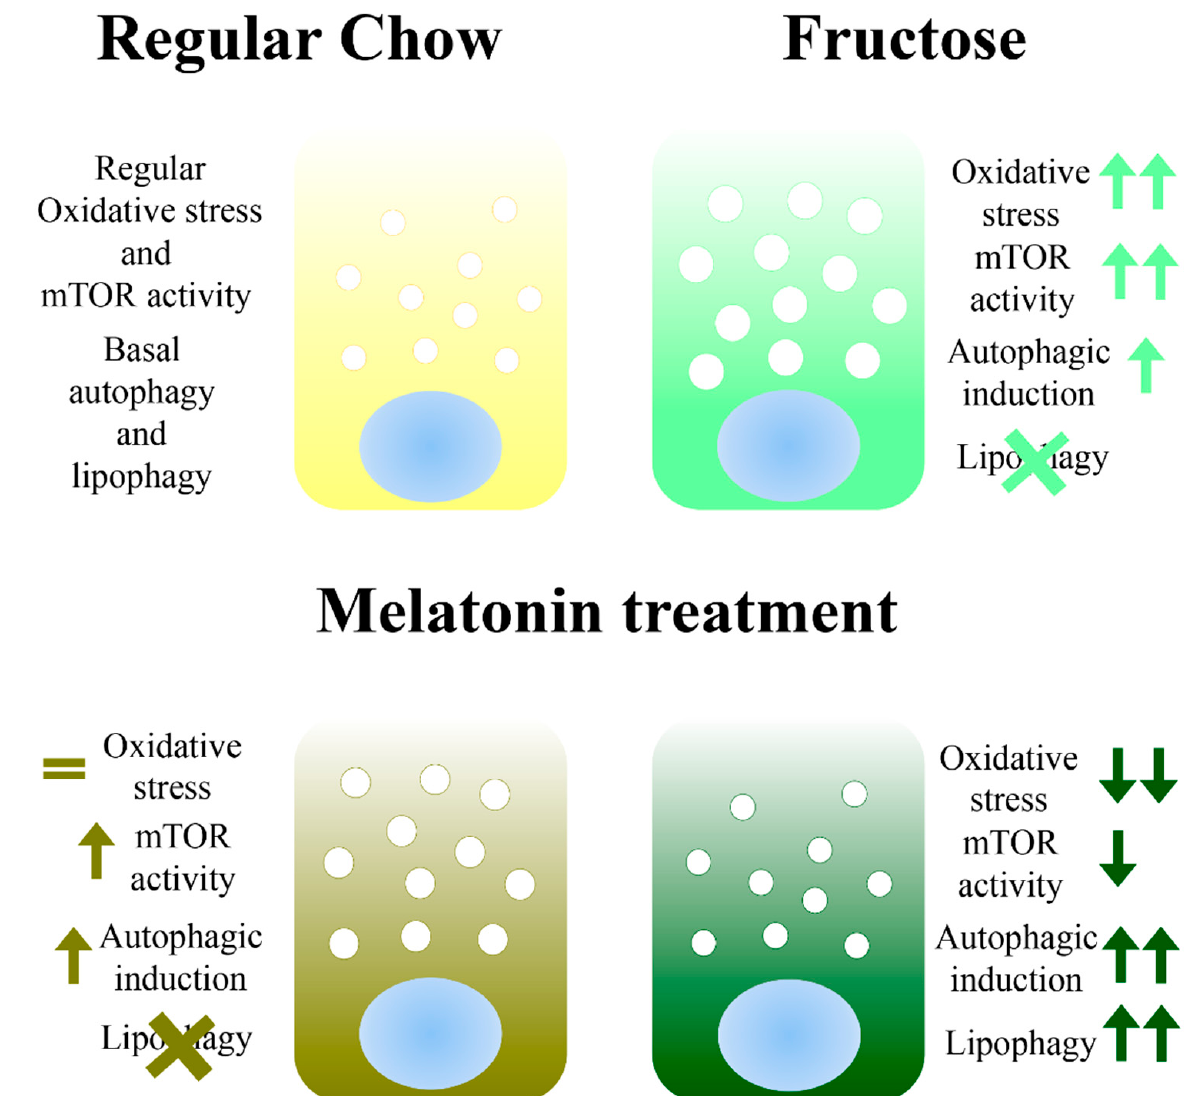
Figure 4. Proposed model—melatonin might have a dual role depending on the cellular situation. When cells are balanced, melatonin activates mTOR that promotes nutrient’s storage. When oxidative stress levels are high, melatonin activates autophagy and selective autophagy, through mTOR inhibition, which have a protective effect.